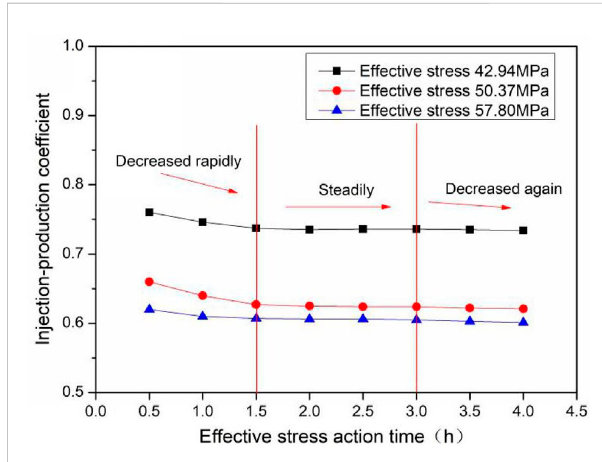
FIGURE 7 Injection-production coef fi cient of different effective stress changes with time.